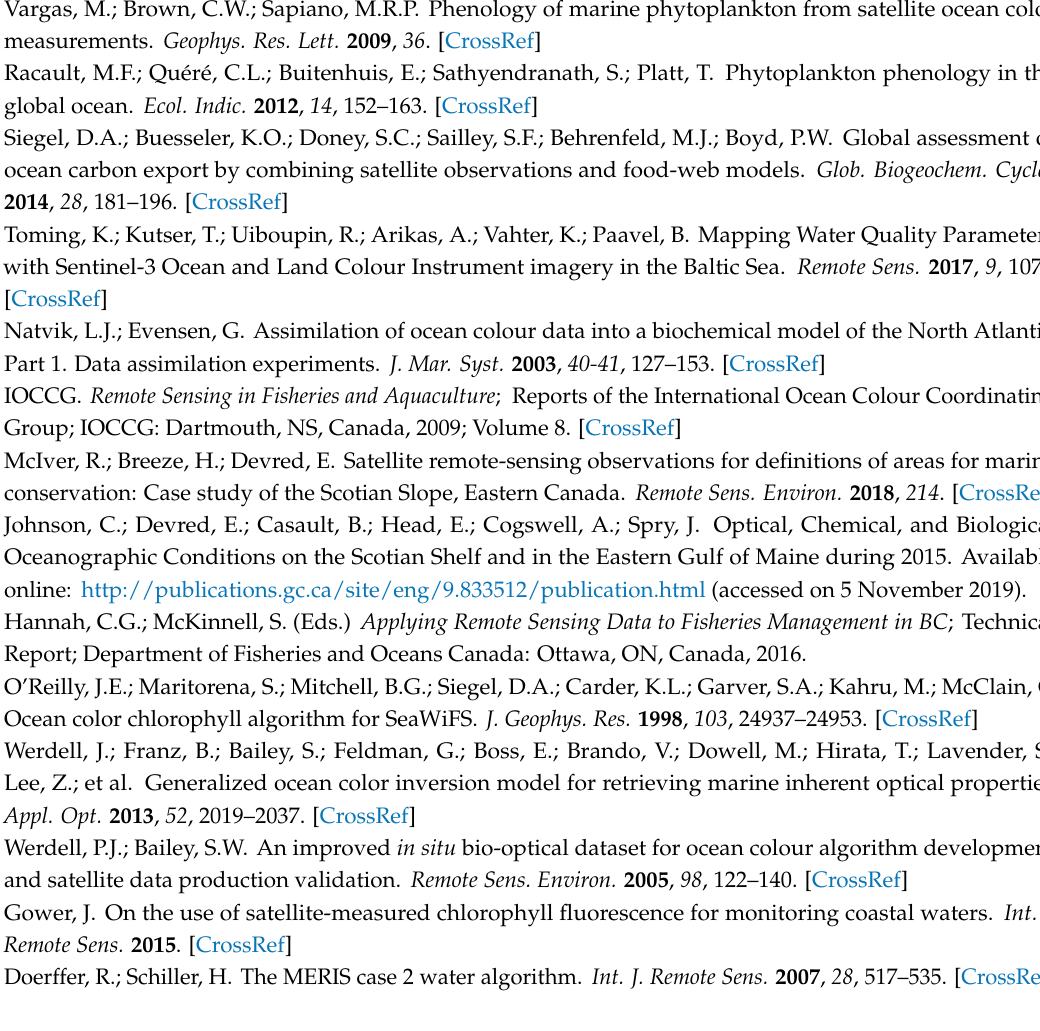
coefficients used in Equation (10) for the wavebands used in ph